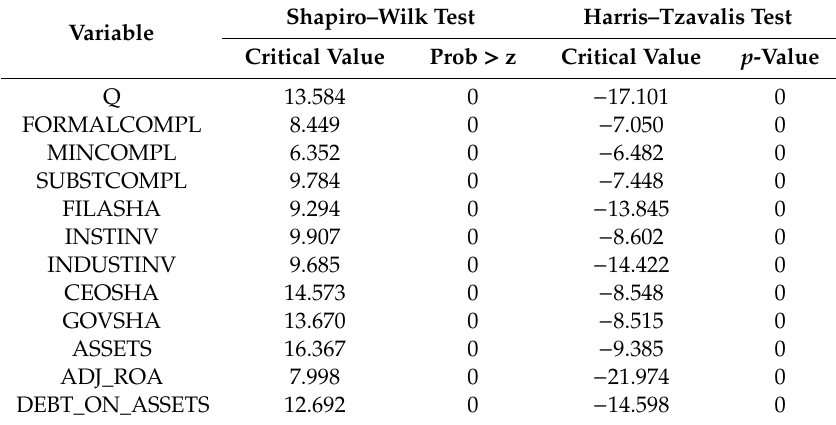
Table 6. Shapiro–Wilk normality test and Harris–Tzavalis stationarity test for variables, and untransformed